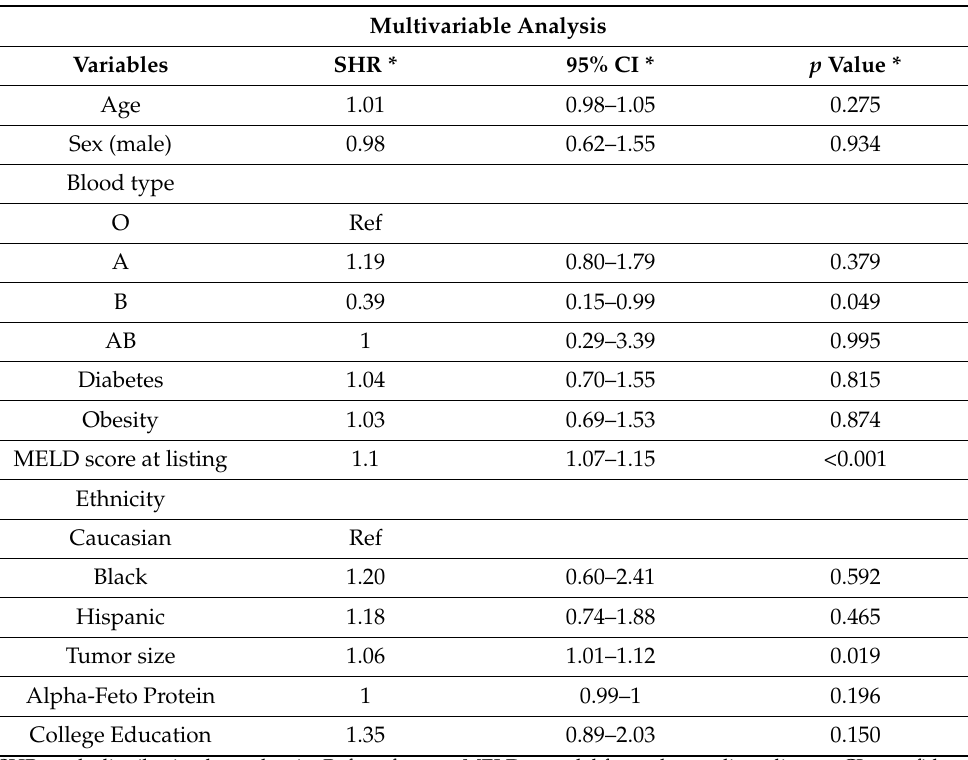
Figure 1. Flowchart of exclusion criteria. Table 2. Multivariable